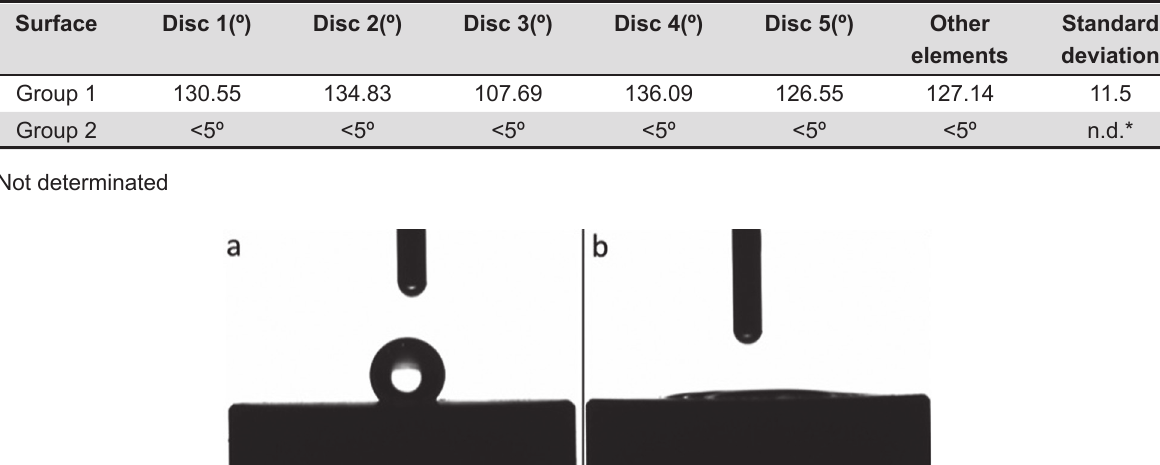
Figure 2- Confocal laser scanning microscopy in the thread region (a) Group 1 and (b) Group 2. No substantial difference between groups was observed (original magnification 20X). The numerical scale (μm) from white (160 μm) and black